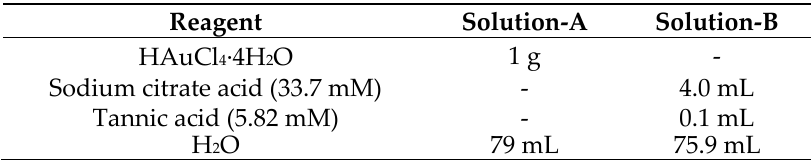
Table 1. The reagents for the synthesis.